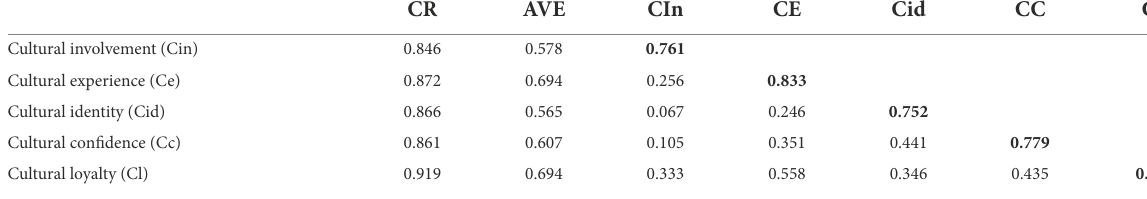
TABLE 3 The discriminant validity.